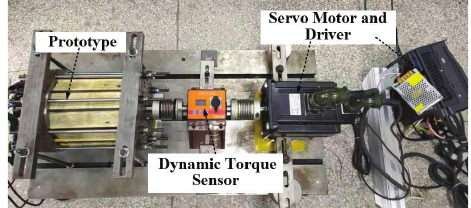
Figure 9. Open circuit experimental setups.